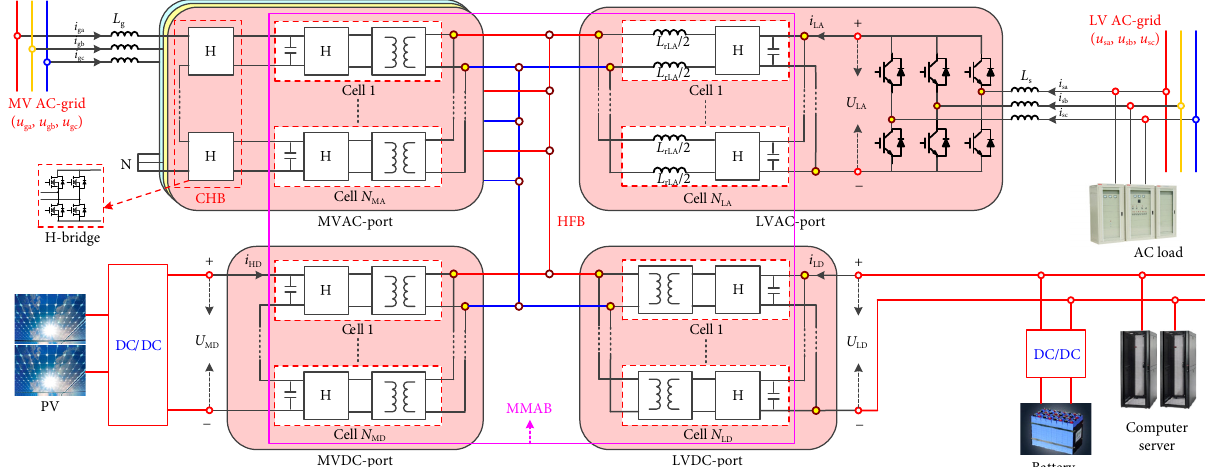
Fig. 1 Four-port high-frequency-bus-based PET used in the data